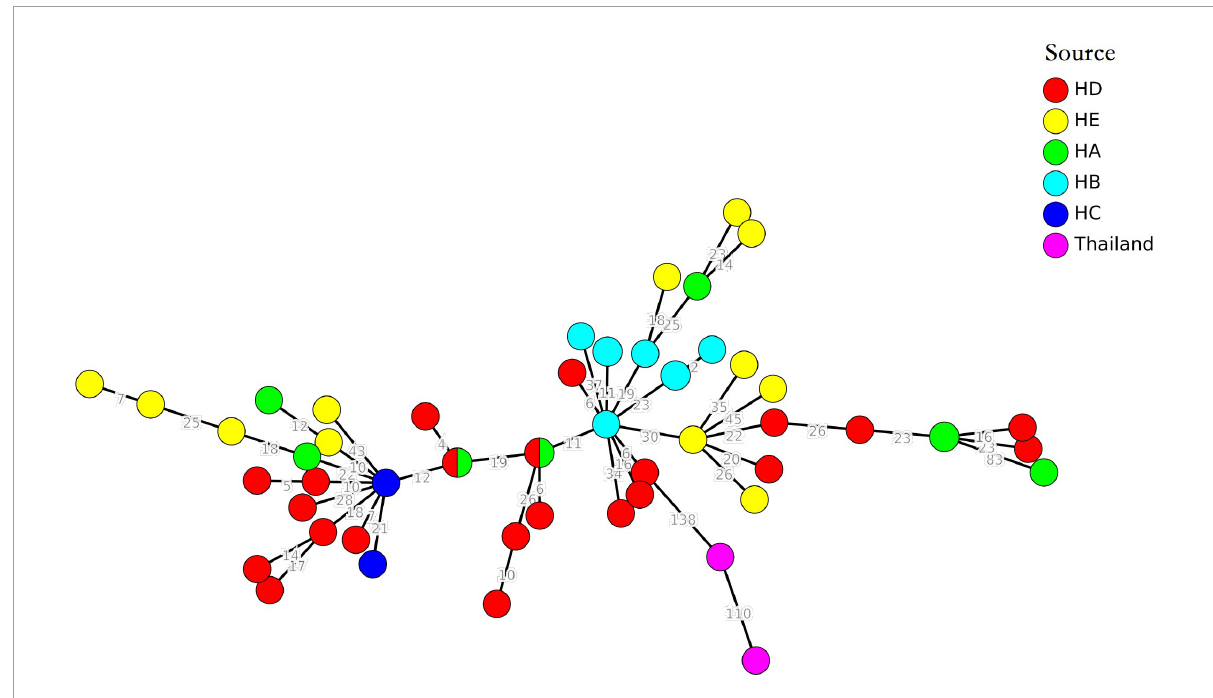
FIGURE3 Minimum spanning tree of 51 ST764-MRSA-II